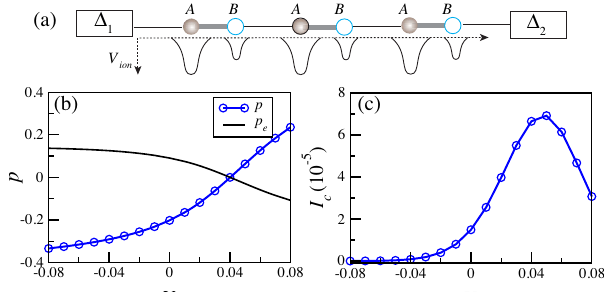
FIG. 4. (a) A schematic diagram for a Rice-Mele model JD, where the tunneling barrier is a 1D Rice-Mele chain. The Rice- Mele chain is formed by sublattices A and B with different on-site potential V . The strong bonds (thick gray lines) and weak ion bonds (thin black lines) are linked to A , B alternatively as in Su- Shrieffer-Heeger model. (b) The polarization density p (unit of e ) as a function of voltage with the electron part contribution p e for the bulk Rice-Mele model. (c) The critical current I c (unit of 2 e= ℏ ) for Rice-Mele chain as a function of voltage, where the I ðþ V Þ ≠ I ð − V Þ demonstrates the diode effect. The other c c parameters are set as t R ¼ t L ¼ t ¼ 1 . 0 , Δ 1 ¼ Δ 2 ¼ 0 . 2 ,